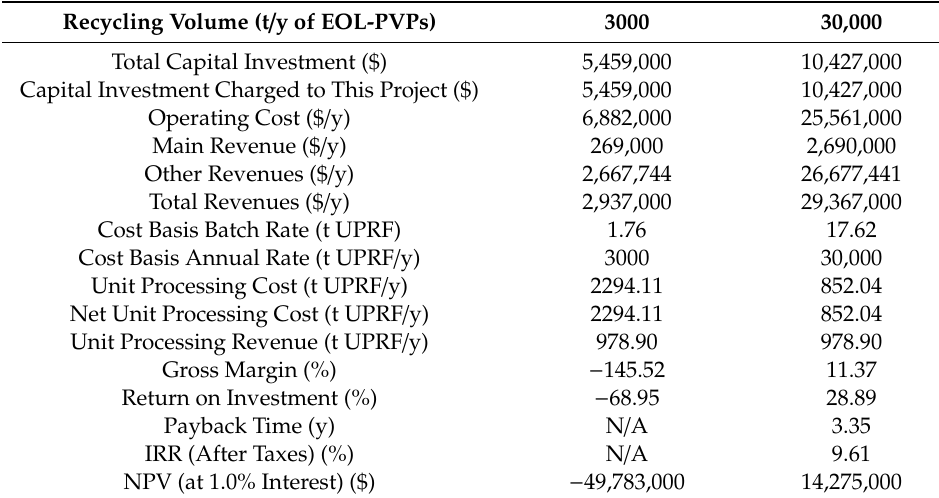
Table 6. Economic outputs of the process for the two recycling